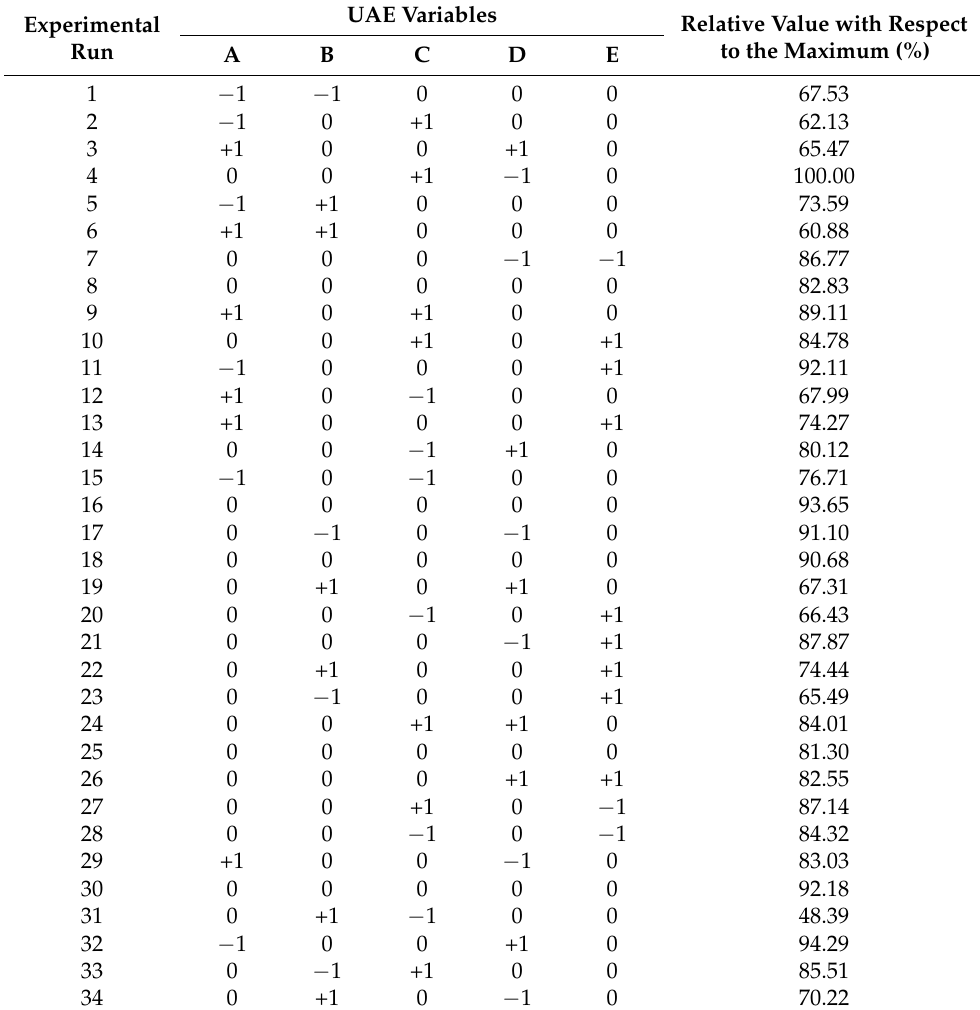
Table 2. Box–Behnken design for the five independent variables with their observed